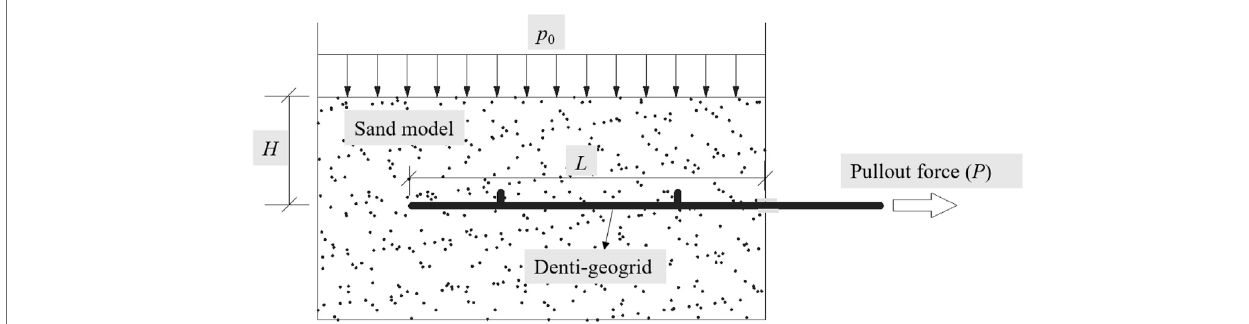
FIGURE 1 | A schematic view of the pullout test.